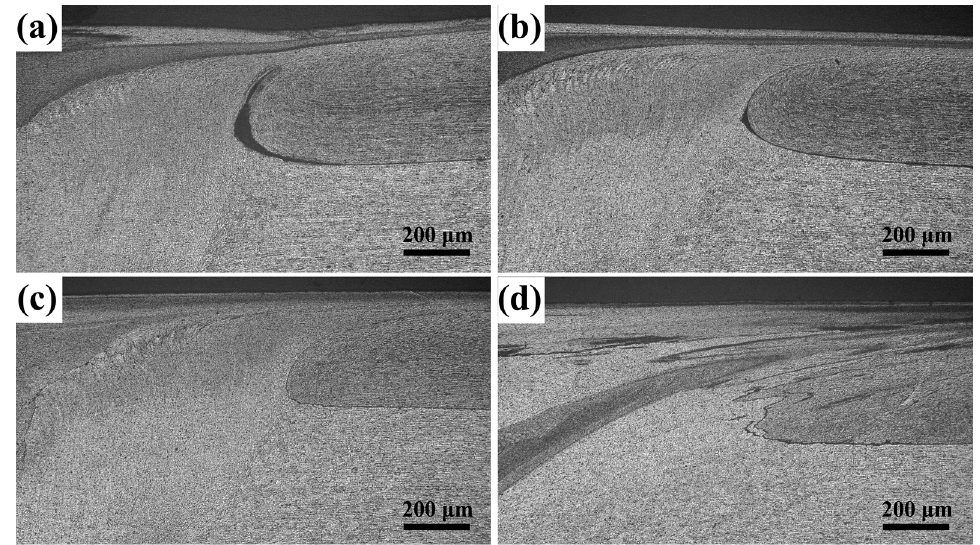
Figure 8. Morphology of the forward side of the edge of the weld seam under different heat input conditions, ( a – d ) refer to the ratio of rotational/welding speeds of 14, 16, 18.67, and 21.33.